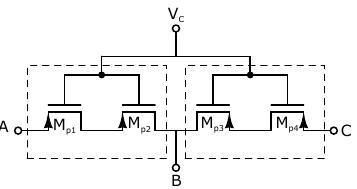
Figure 3. CMOS OTA that allows programmability of g m .